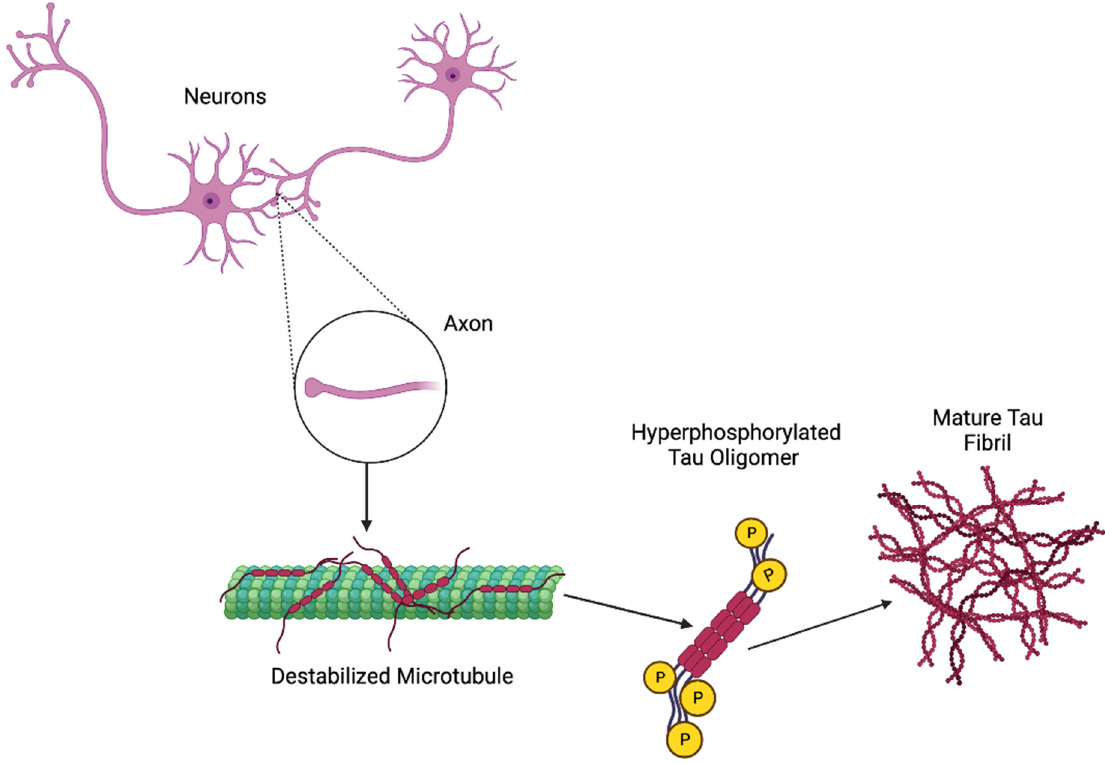
Figure 5. Possible pathogenesis mechanism of tau.